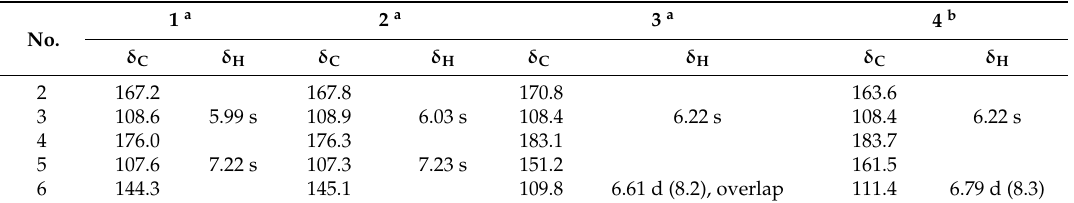
Table 1. 1 H- (500 MHz) and 13 C- (125 MHz) NMR spectral data of compounds 1 – 4 ( δ in ppm, J in Hz). No.